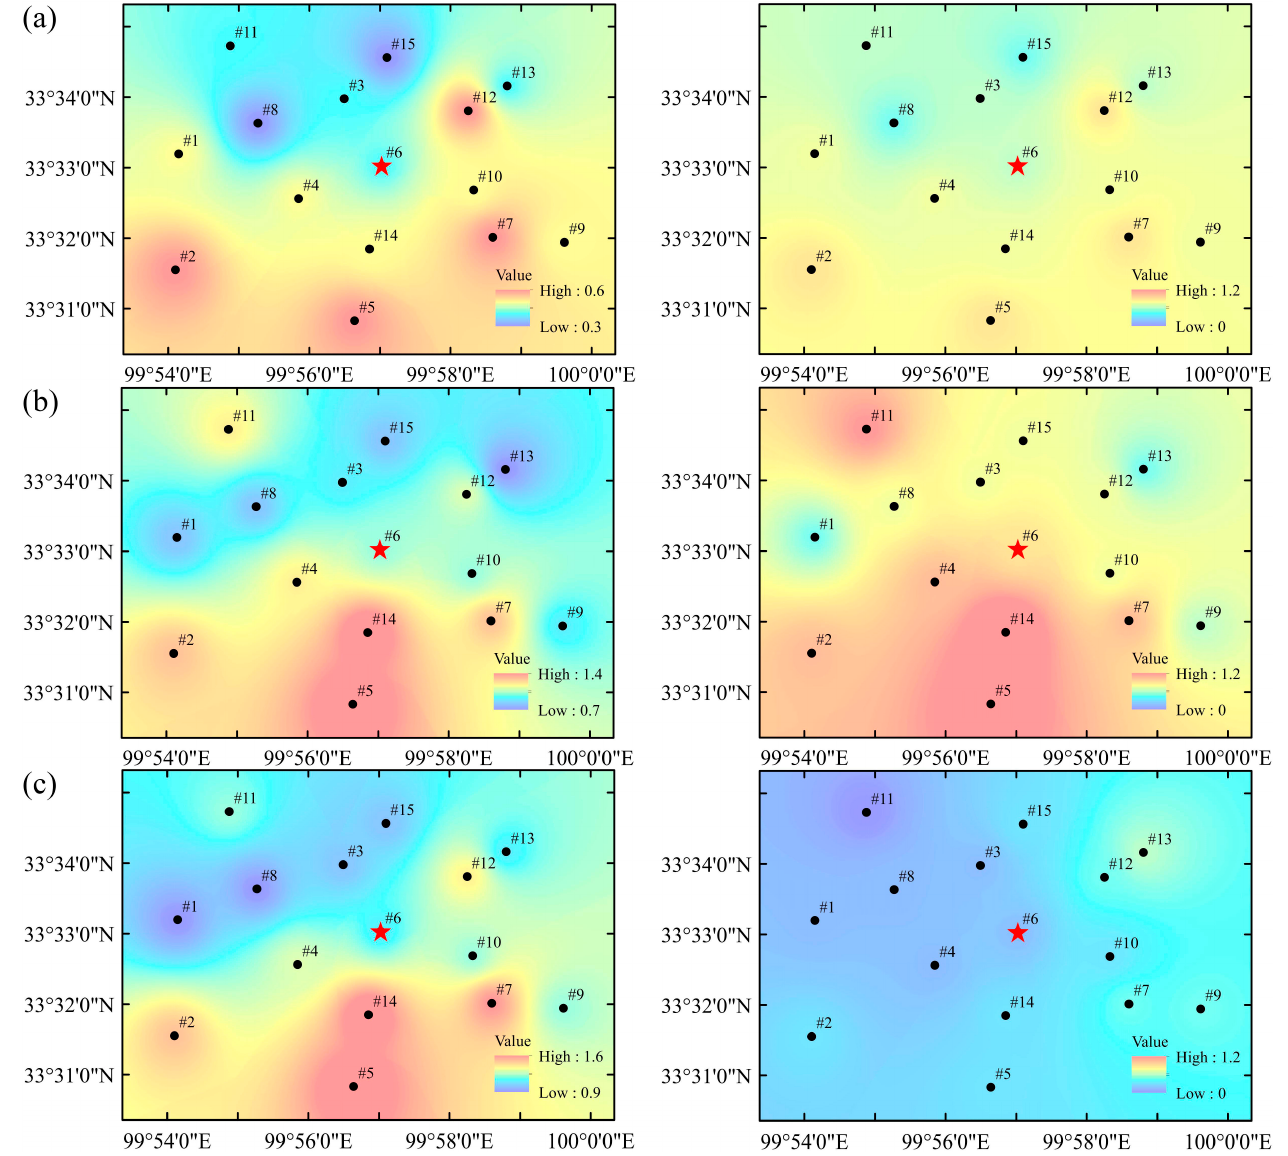
Figure 10. Temporal evolution of R and accumulated rainfall measured by rain gauges in the zenith direction of the field site. ( a ) t 1 = 6:00–6:40, ( b ) t 2 = 6:40–7:20, ( c ) t 3 = 7:20–8:00. The pentagram and solid circle symbols present position of field site and rain gauges, respectively.